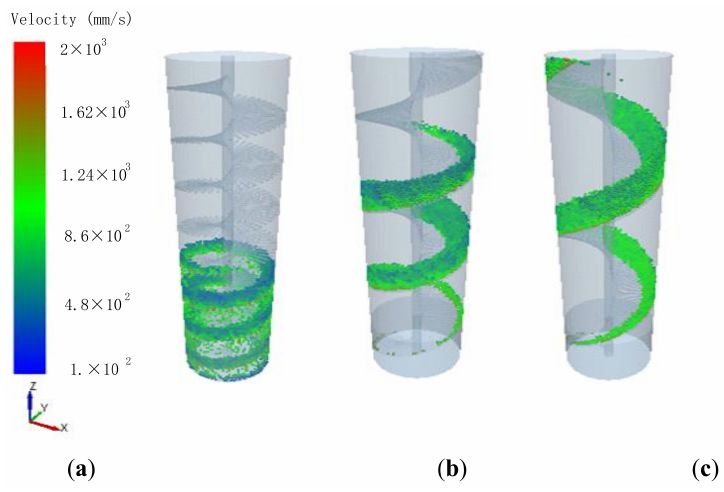
Figure 9. Different angles simulation results. ( a ) spiral angle 10 ◦ ; ( b ) spiral angle 20 ◦ ; ( c ) spiral angle 30 ◦ .